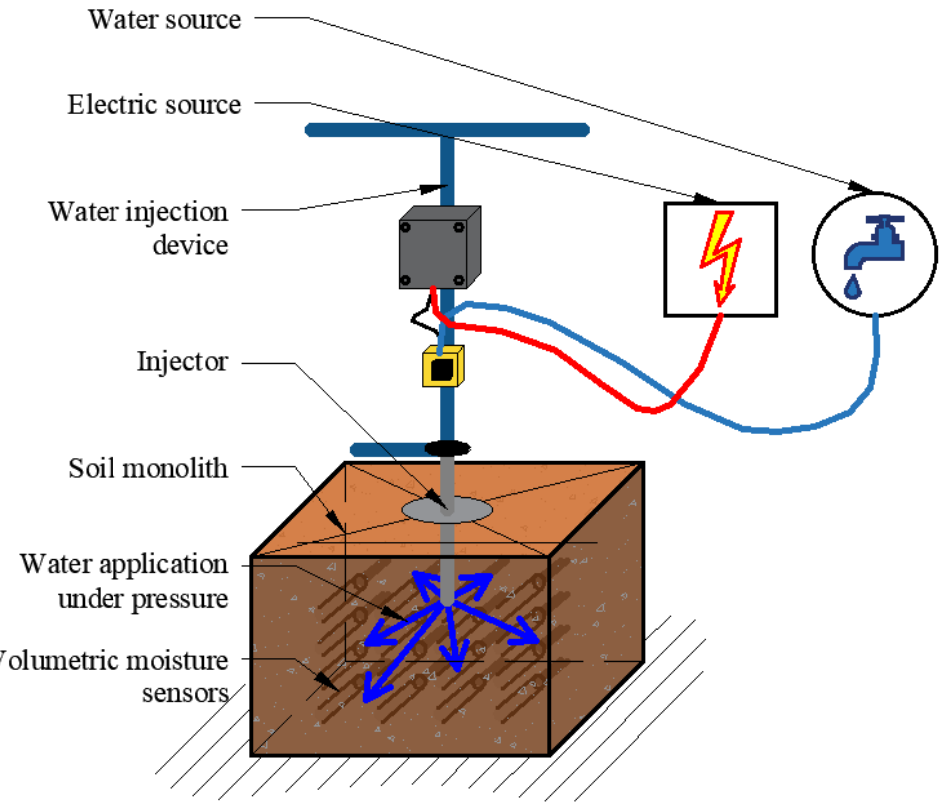
Figure 2. Schematic presentation of the experiment setup.